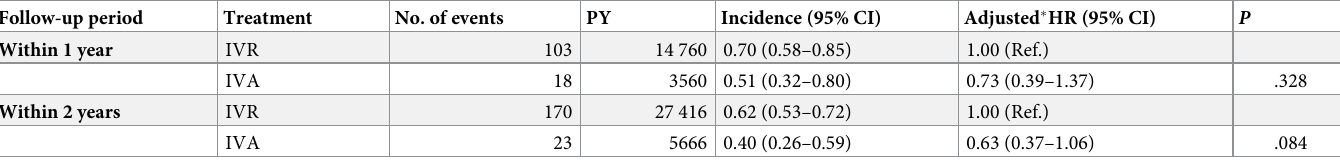
Table 3. Incidence (per 100 PY) and adjusted HR of glaucoma during 1-year and 2-year follow-up periods. Follow-up period Treatment